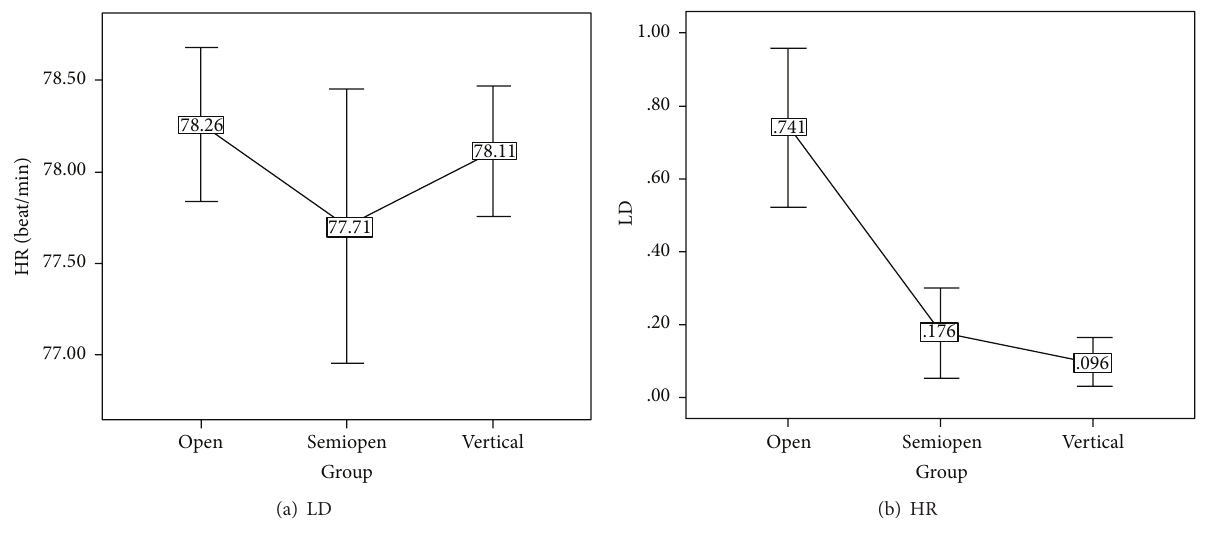
Figure 5: Error bar chart of LD (a) and HR (b).